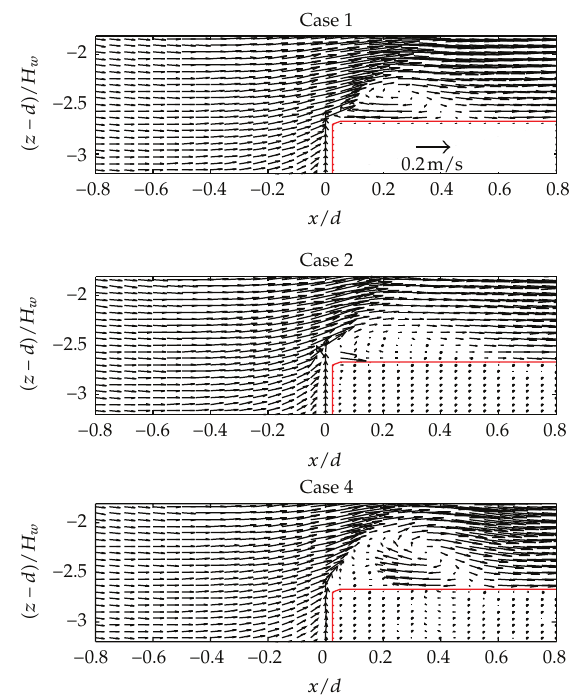
Figure 6: Velocity field at t (cid:2) g/d (cid:3) 0 . 5 (cid:7) 49 as a solitary wave passes over a submerged impervious (cid:2) Case 1 (cid:3) and two di ff erent permeable breakwaters (cid:2) Cases 2 and 4 (cid:3)